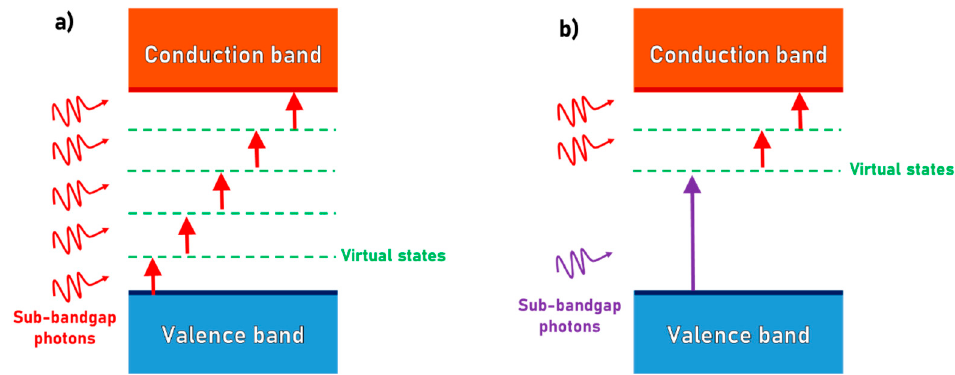
Figure 1. Schematic depiction of ( a ) multiphoton absorption of sub-bandgap photons and ( b ) multiphoton absorption of dual-wavelength double-pulse irradiation.